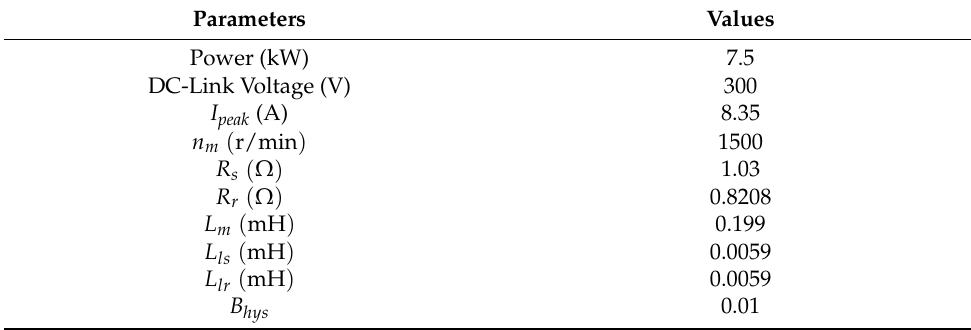
Figure 7. General view of the experimental setup. Table 1. Asymmetrical six-phase IM parameters.